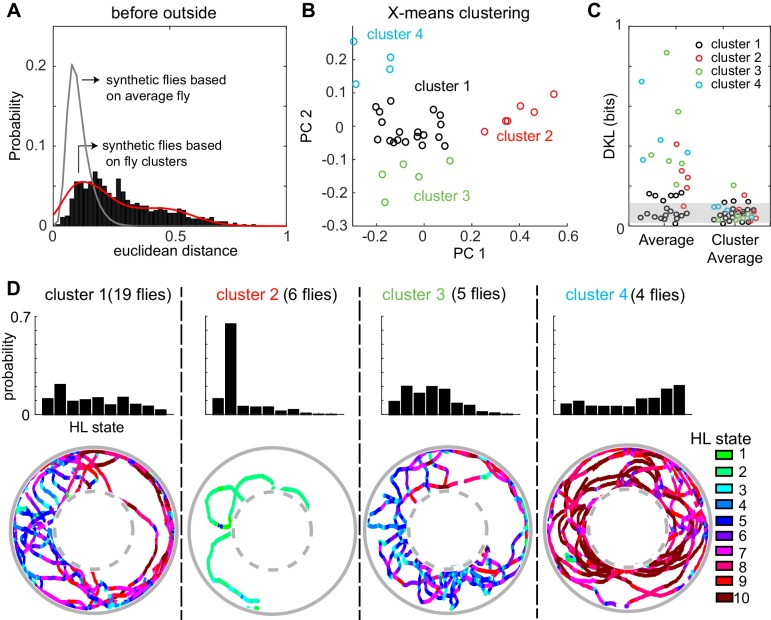
A fly’s locomotion cannot be explained as variations around an average fly and is well-described on the basis of three to four locomotor types.(A) Histogram of distances between flies in the 10-dimensional space formed by the HL states. The distance between 100 iterations of 34 synthetic flies based on the average distribution of states is much smaller (gray line, Wilcoxon rank sum test, p < 10−131). The distance between synthetic flies drawn from four clusters of flies (red line) has a distribution more similar to the empirical distribution. (B) X-means clustering (a variant of K-means) in the 10-dimensional HL state space. Only the first two PCs are shown. Each cluster is represented by a different color. (C) Left: KL divergence from the average fly to the individual fly (n = 34). Right: KL divergence from the average fly in each cluster to each individual fly in the corresponding cluster. Shaded area reflects the expected KL divergence (99% of KL divergences) from the HL state distribution of the average fly to the HL distribution of synthetic flies generated from this average (n = 3400). (D) Average HL state distribution for each cluster is shown in the top row. Bottom row shows an example fly for each cluster with HL states overlayed.